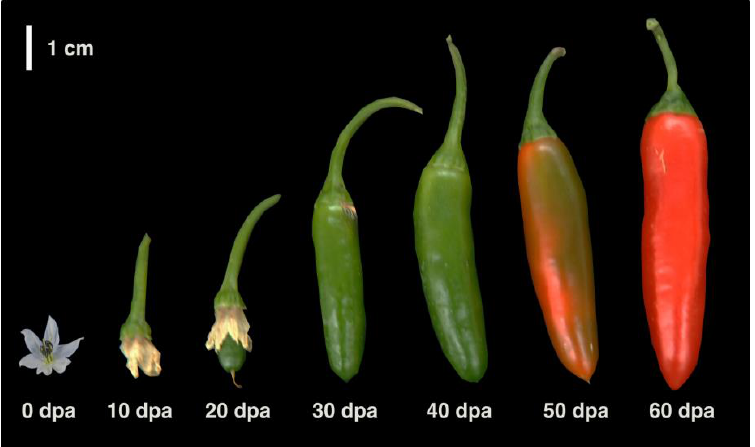
Figure 5. Serrano “Tampiqueño 74” fruits throughout developmental stages. Flower (0 dpa;